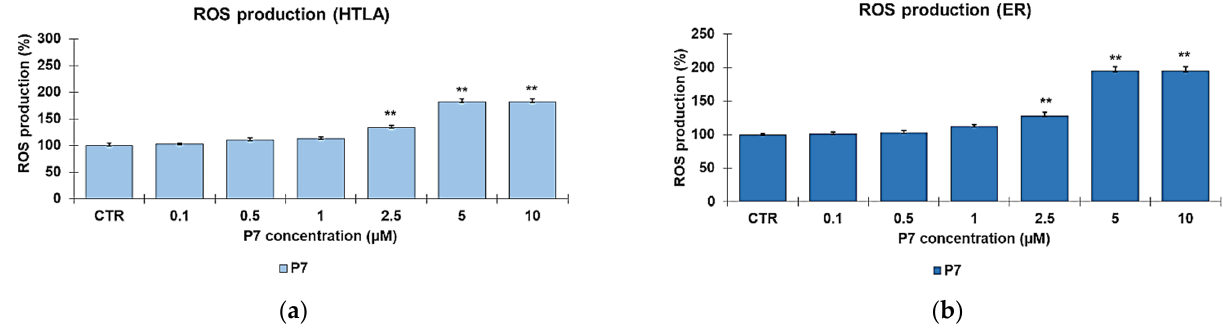
SEM of three independent experiments. ** p < 0.01 vs. Ctr cells. of three independent experiments. ** p < 0.01 vs. Ctr cells.